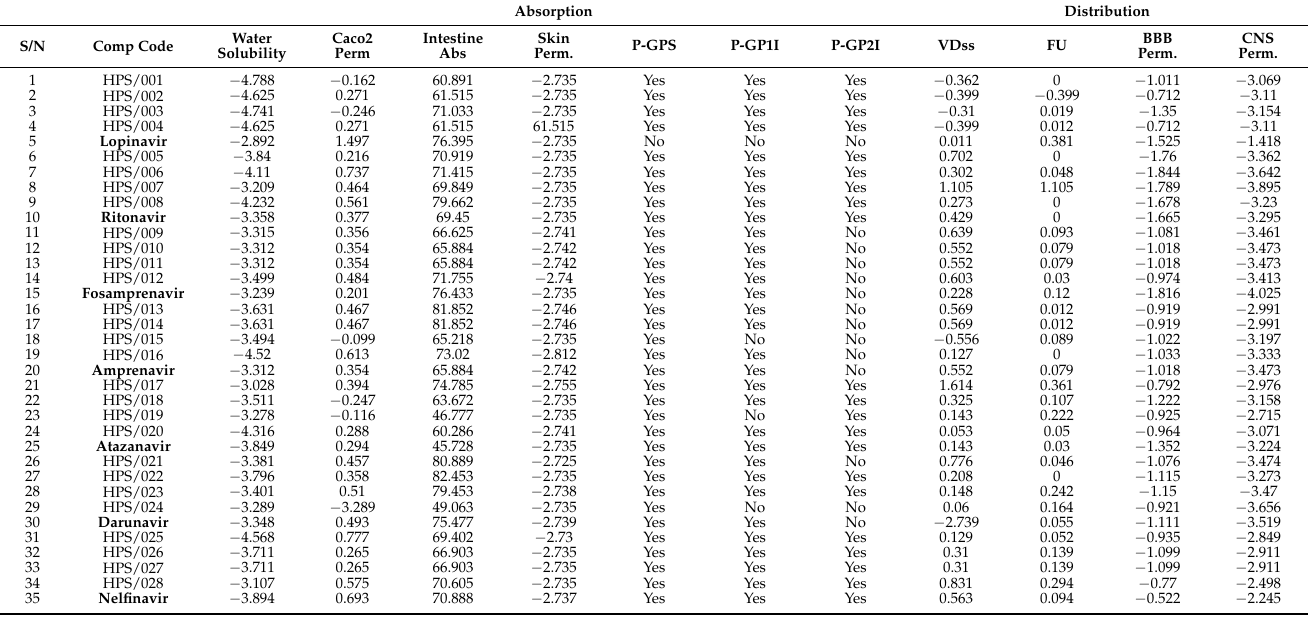
Table 4. Absorption and distribution